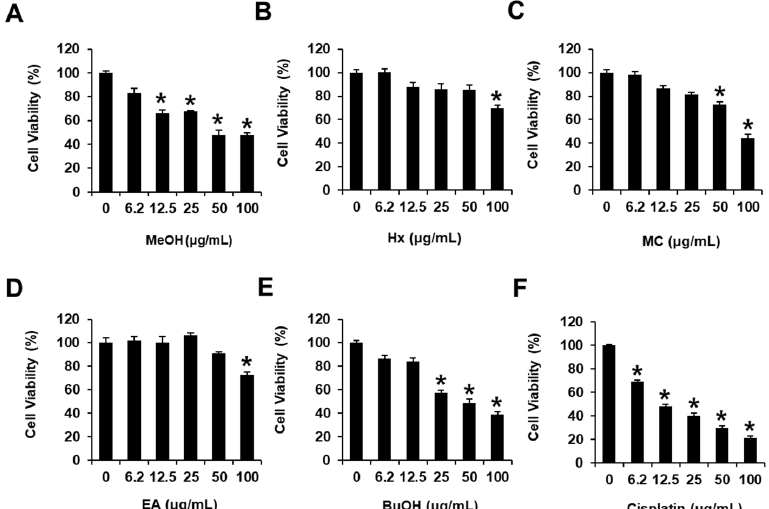
Figure 1. Effects of the MeOH extract of Withania somnifera roots and hexane (Hx), dichloromethane (MC), ethyl acetate (EA), and n -butanol (BuOH)-soluble fractions on human hepatocellular carcinoma (HepG2) cell viability. HepG2 cells were treated with ( A ) MeOH extract (MeOH), ( B ) Hx, ( C ) MC, ( D ) EA, ( E ) BuOH-soluble fractions, and ( F ) cisplatin (6.2, 12.5, 25, 50 and 100 μ g/mL) for 24 h. Cells were treated with culture media containing 0.5% DMSO as vehicle controls. The MTT assay assessed HepG2 cell viability. Data are presented as the mean ± standard error of the mean (SEM). n = 3, * p < 0.05 compared with the control.